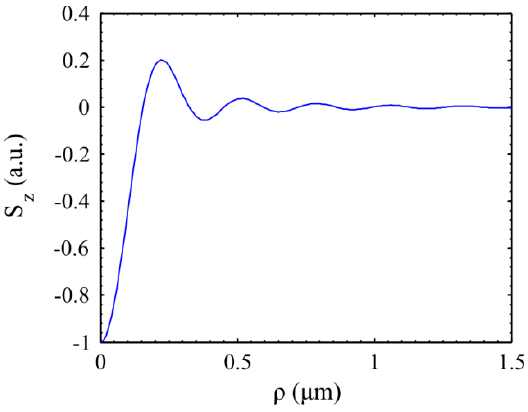
Figure 1. Plot of the function J 22 ( k ρ ) − J 02 ( k ρ ).